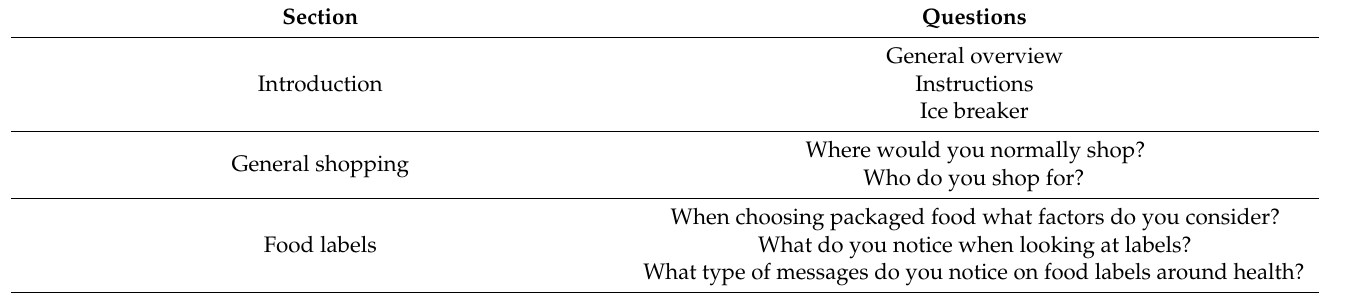
Figure A2. In-depth interview guide stimulus activity 2. Table A2. Focus Group Question Guide.